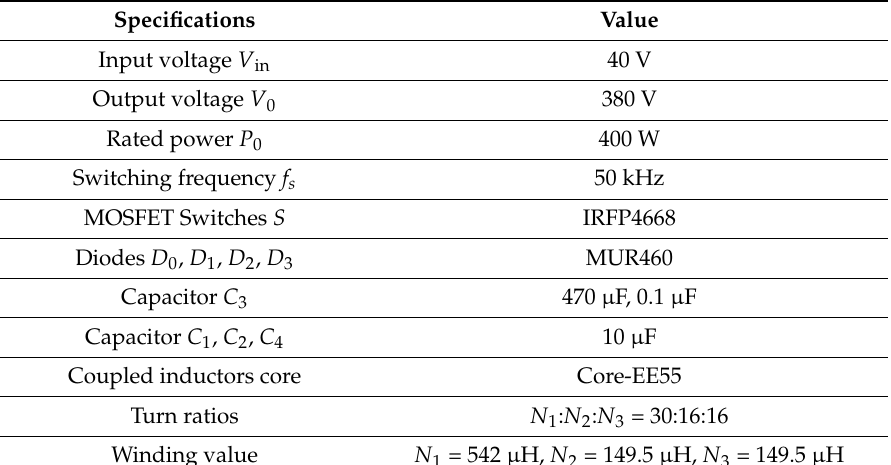
Table 3. System specifications of the proposed converter.